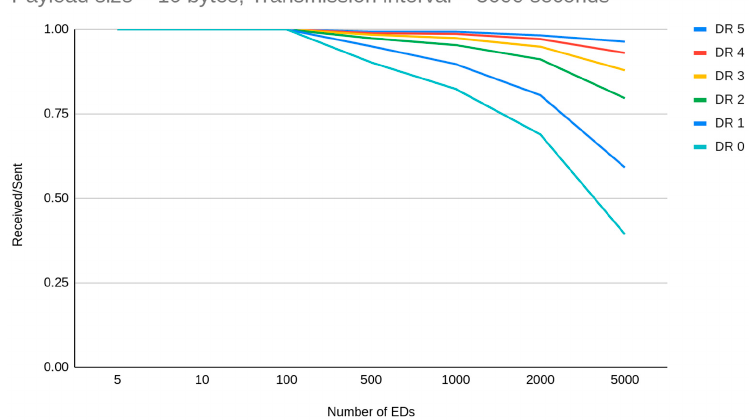
Figure 4. How DR allocation affects network capacity.